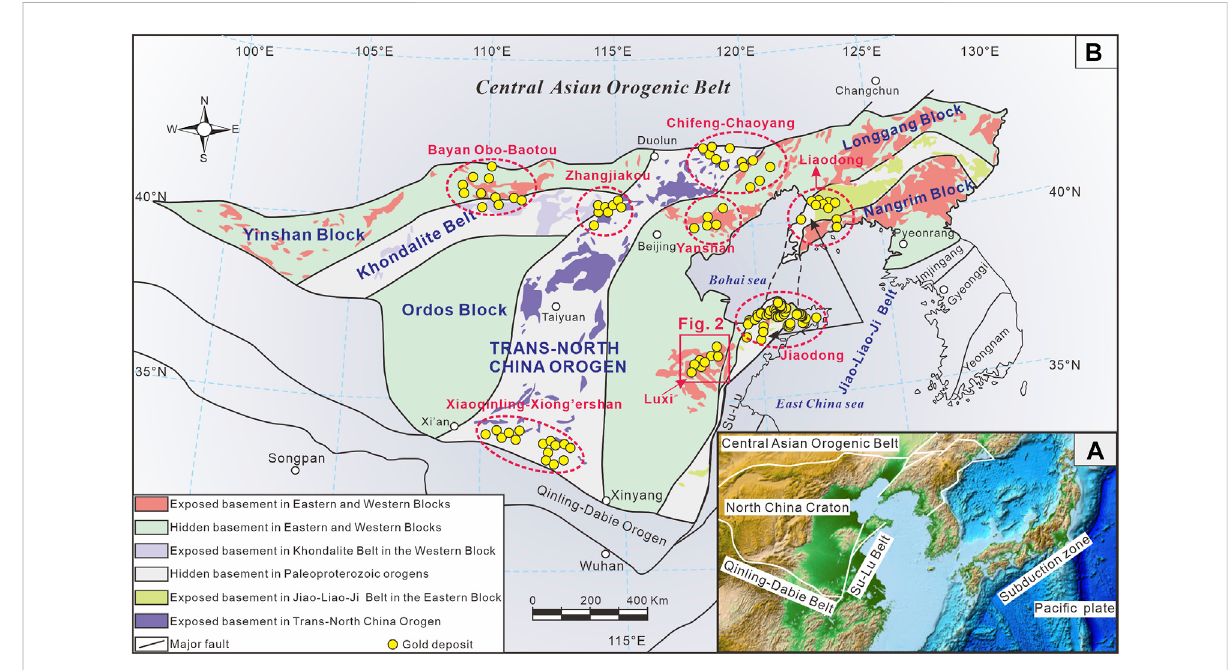
FIGURE 1 (A) Simpli fi ed geological and tectonic map of the NCC (modi fi ed after Yang et al., 2021); (B) Geological map with the distribution of gold deposits in the NCC (modi fi ed after Zhao et al., 2005; Deng and Wang, 2016; Li and Santosh, 2017; Li et al.,